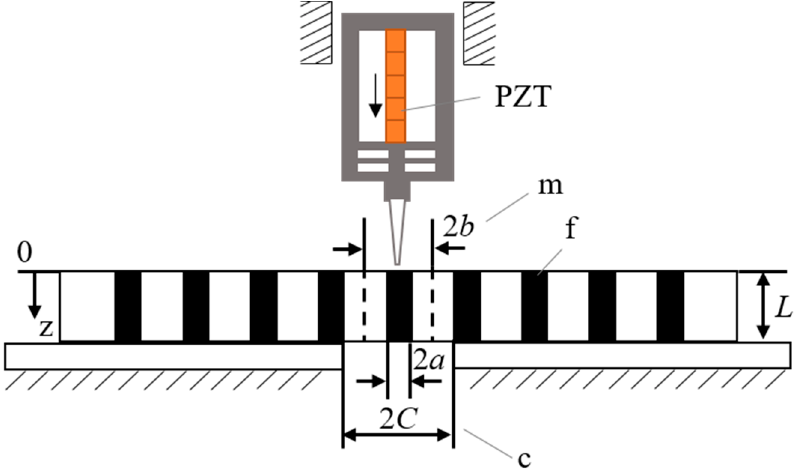
Figure 11. Theoretical model of the system.